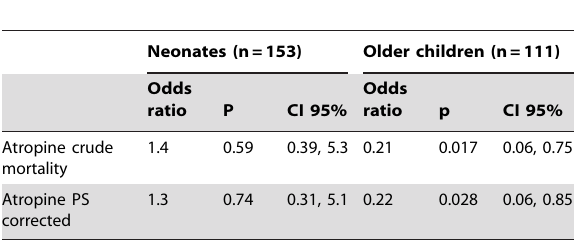
Table 3. ICU mortality related to atropine use corrected by the propensity score (PS) in the two age subgroups. Neonates are # 28 days of age and older children . 28 days and less than 8